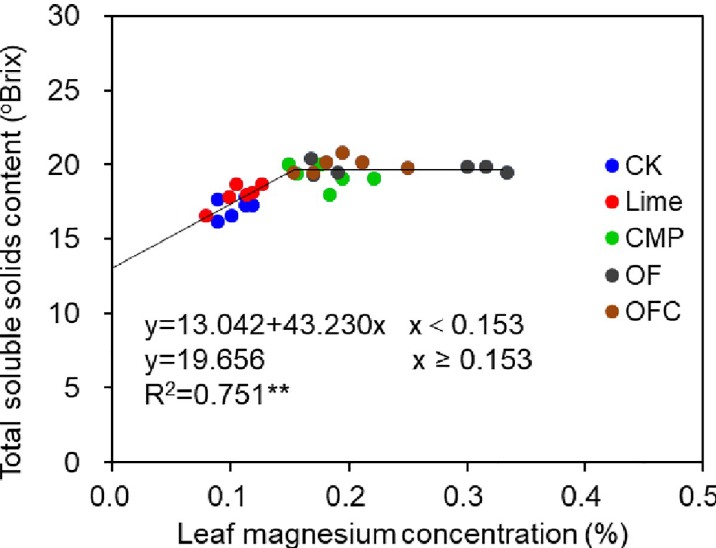
Fig 5. Relationship between leaf Mg concentration and total soluble solids content. The plants were grown in soil amended with lime (Lime), calcium magnesium phosphate fertilizer (CMP), organic fertilizer (OF), organic fertilizer with calcium magnesium phosphate fertilizer (OFC) or remained unamended (control, CK). Asterisks indicate significant difference at P < 0.01( �� ).